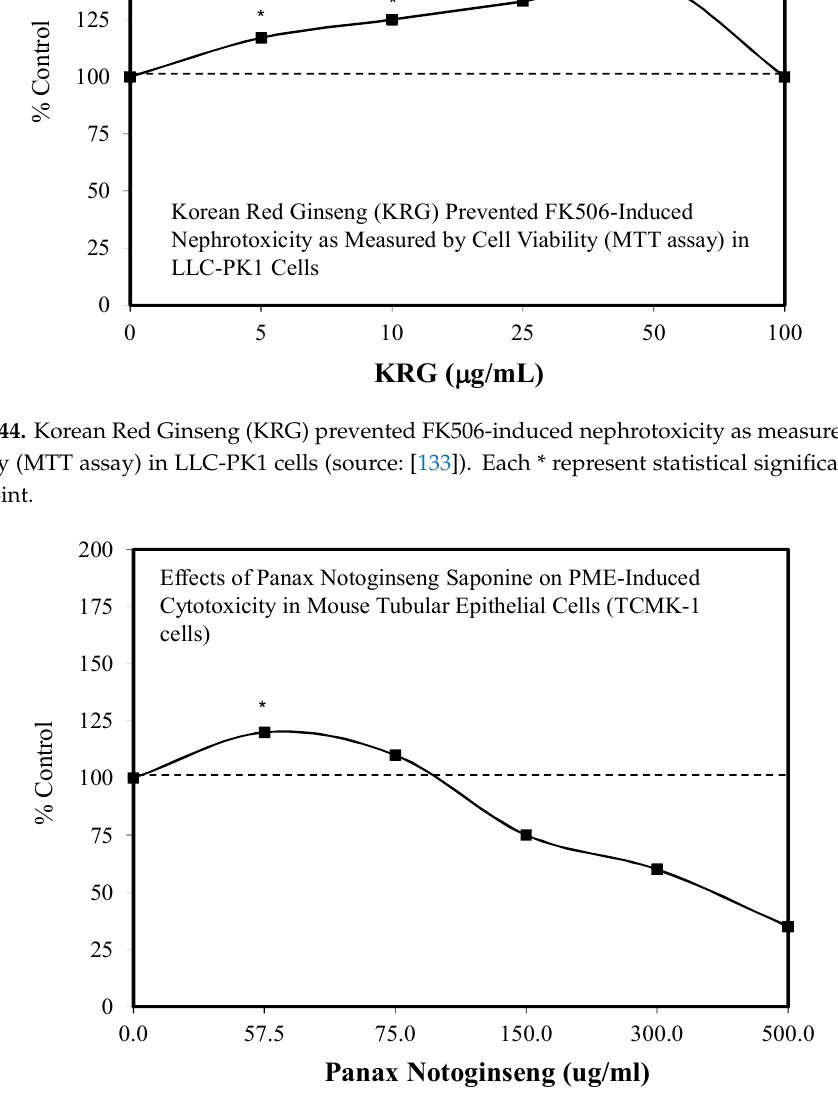
Figure 45. Effects of Panax notoginseng saponine on PME-induced cytotoxicity in mouse tubular epithelial cells (TCMK-1 cells) (source: [144]). Each * represent statistical significance for a data point.